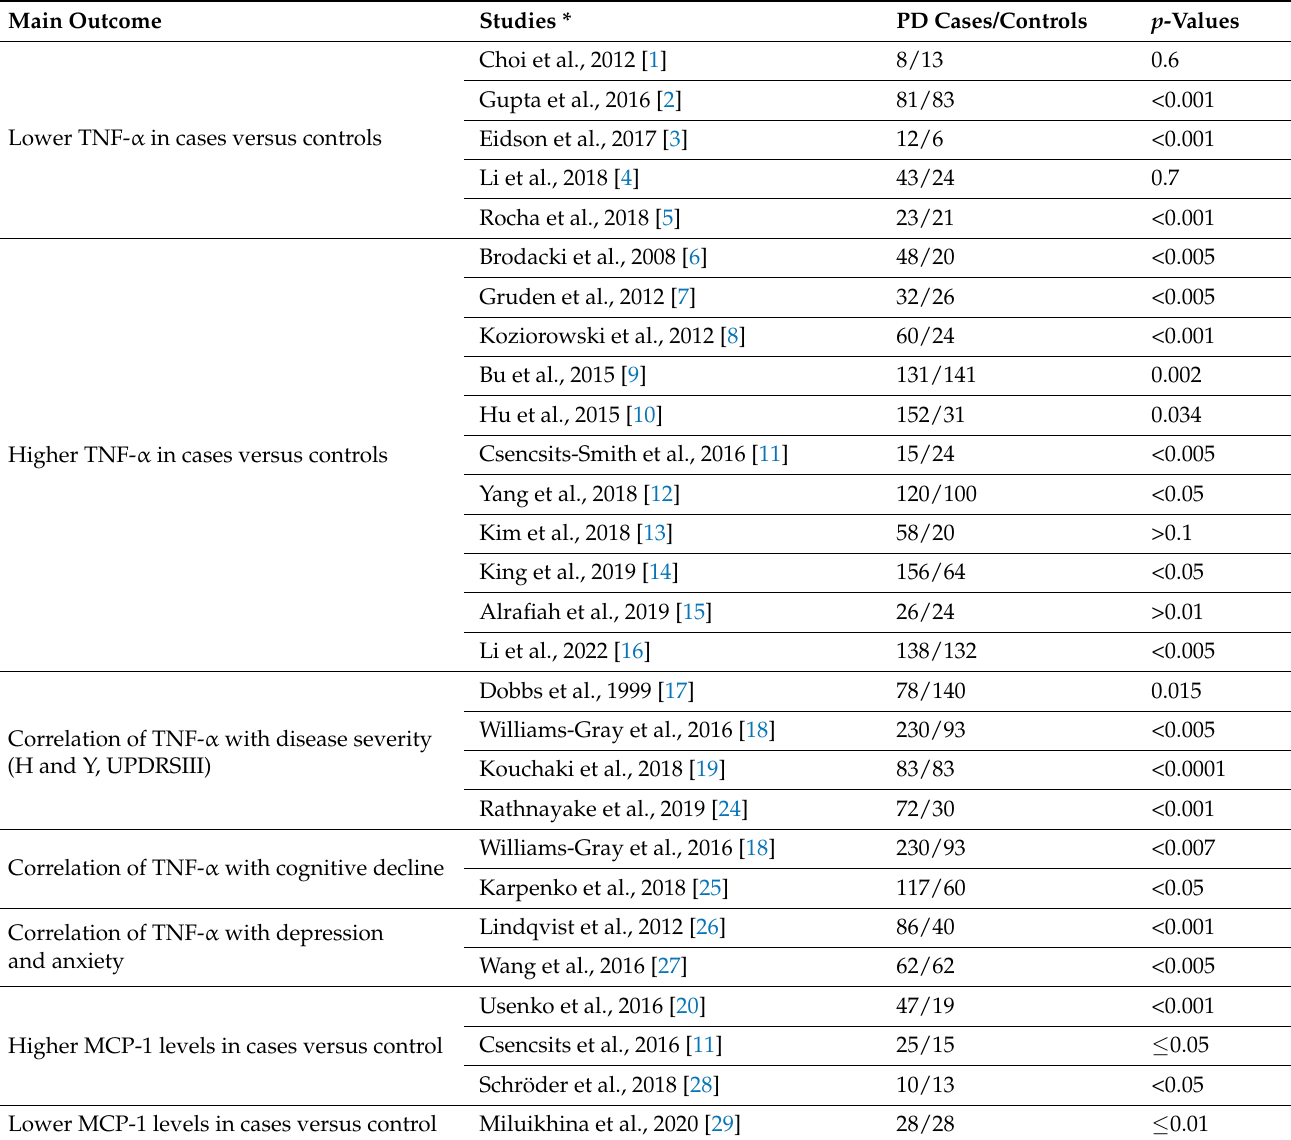
Table 2. Summary of outcomes of measurement of peripheral TNF-a and MCP-1 levels in Parkin- son’s